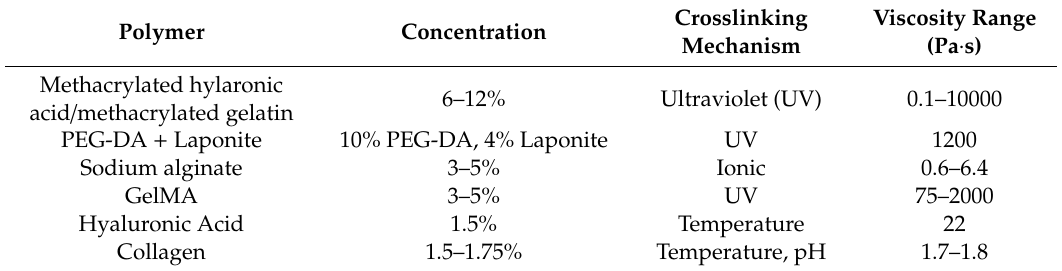
Table 1. Properties a ff ecting shear stress and viability of some common polymers